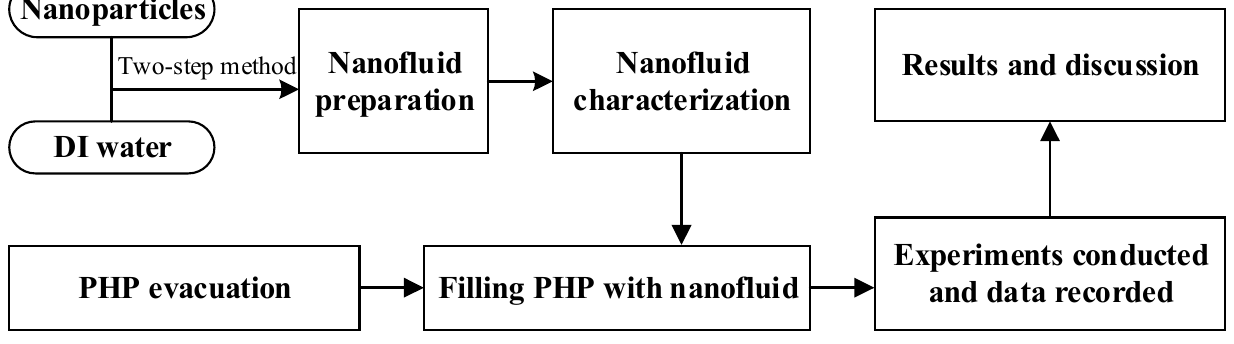
Figure 5. The methodology flowchart .